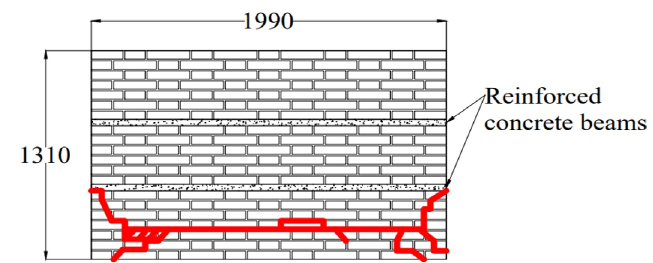
Figure 3. Failure of plain wall with reinforced concrete beams